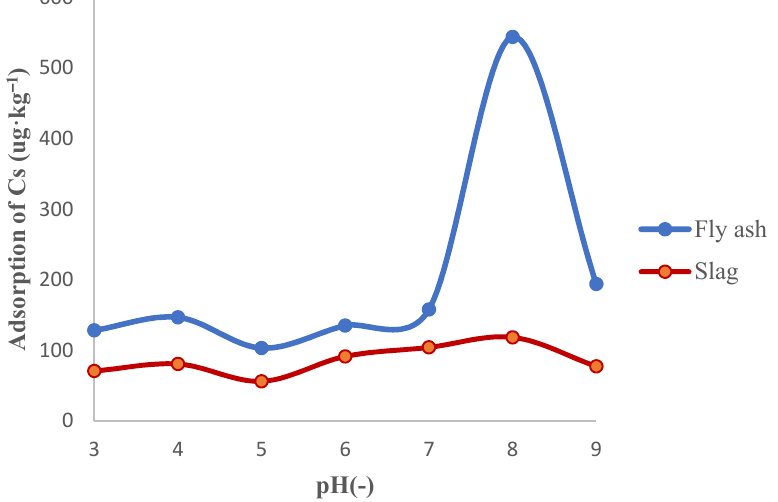
Figure 1. Effect of pH on the adsorption of Cs by fly ash-based geomaterials and slag-based geomaterials.